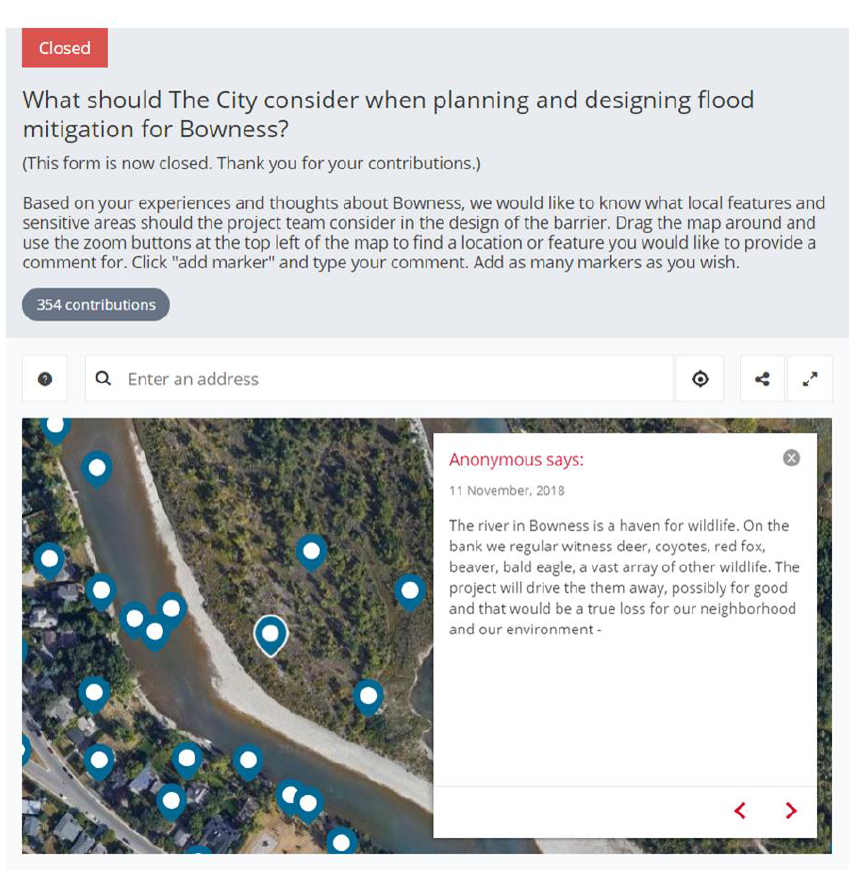
Figure 3: City of Calgary collecting citizen opinions on their ‘Engage’